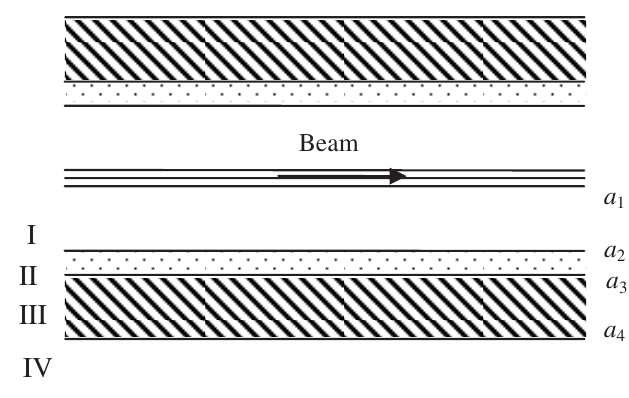
pipe.*wangn@ihep.ac.cn †